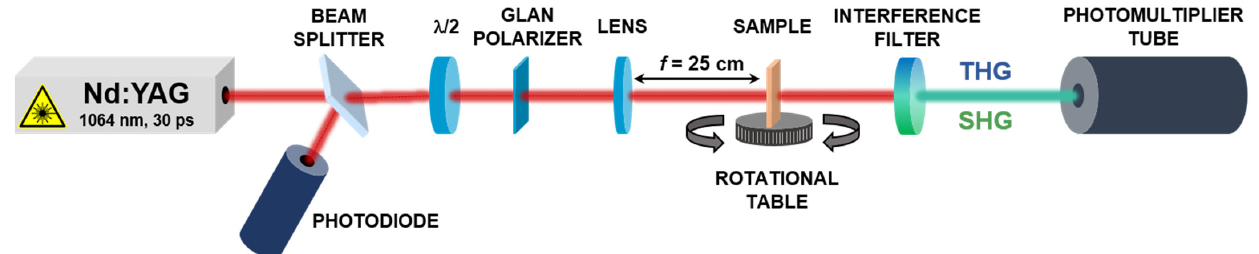
Figure 2. Second and third harmonic generation experimental setup. The following optical elements were used in the research: beam splitter for splitting the beam, one of which goes to the photodiode to detect the signal and possible noise, while the other passes through a half-wave plate, which changes the beam polarization. Then, after passing through Glan’s polarizer, according to which is possible to have less reflection loss, the sample passes to the lens at a distance of 25 cm from the sample. The interference filter positioned downstream of the sample is used to cut off nonessential signals and select the response to be studied. For SHG, it is a 532-nm filter. For THG, it is a 355-nm filter.